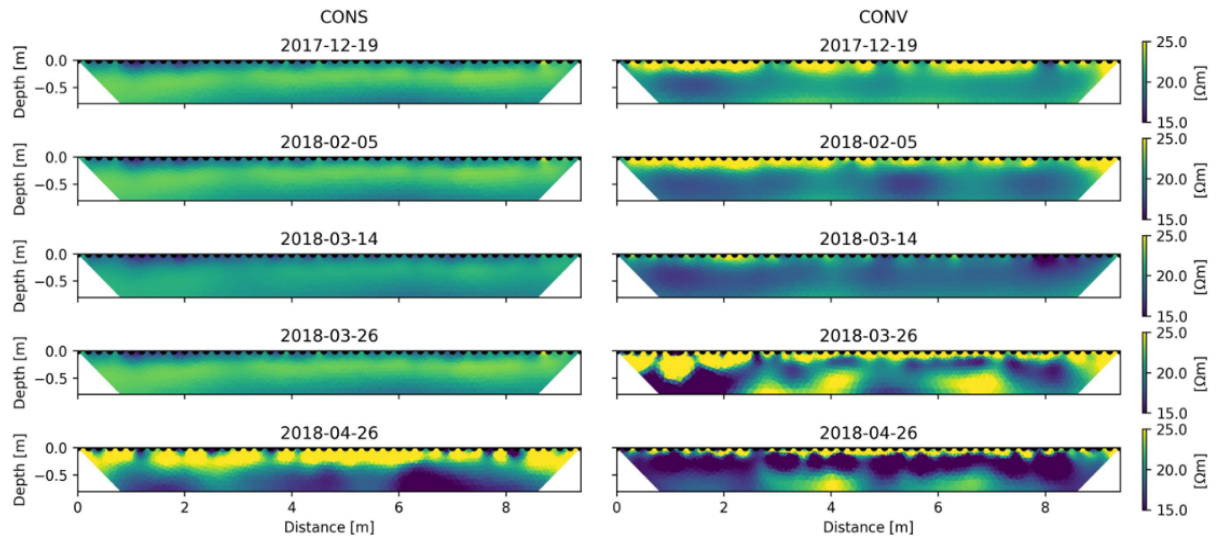
Figure 5. Absolute inverted ER values along the ERT transects over time, respectively, for the conservative ( left ) and the conventional treatment ( right ).